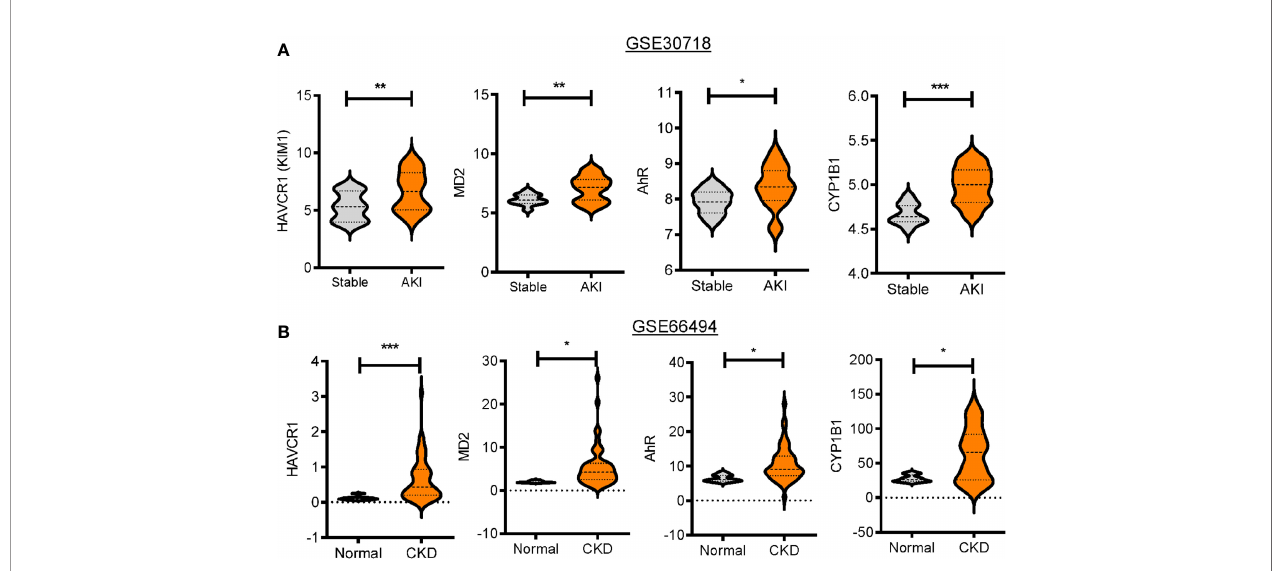
FIGURE 1 | Expression pro fi les of bacterial dysbiosis-responsive biomarker genes in patients with renal distress. Expression of bacterial dysbiosis-responsive biomarker genes was assessed in patients with acute kidney injury (gse30718, n = 47, A ) or chronic kidney disease (gse66494, n = 61, B ). Results are shown in the violin plot as mean values ± SD and the asterisks ( ∗ ) indicate signi fi cant differences between two groups using Student ’ s t-test (*p < 0.05, **p < 0.01, ***p <